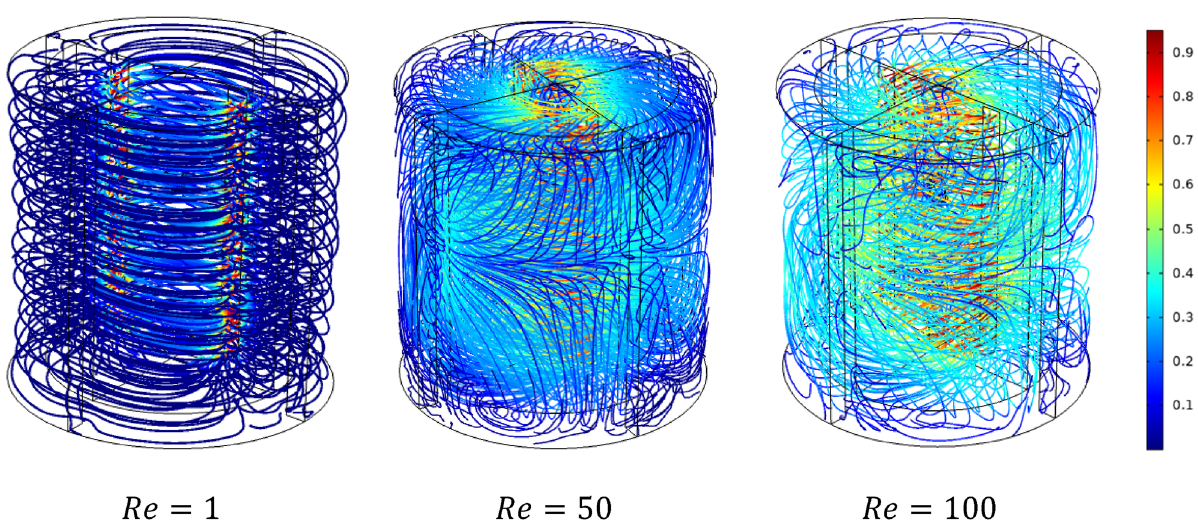
Figure 19. Streamline distribution along stirred vessel for Bn = 10 with inertia variation